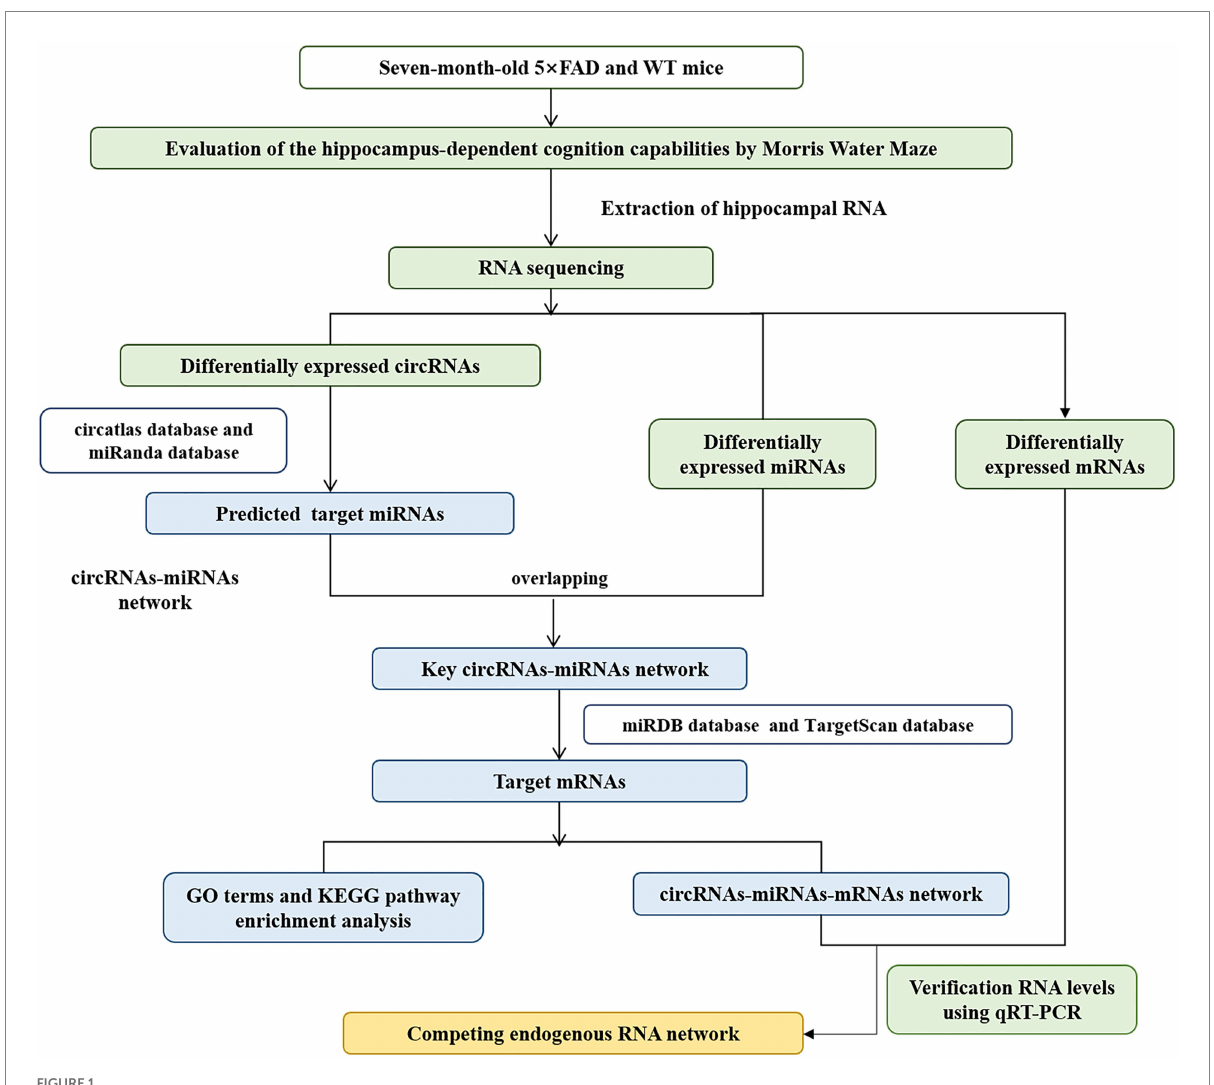
FIGURE 1 Workflow for circRNA analysis and ceRNA network